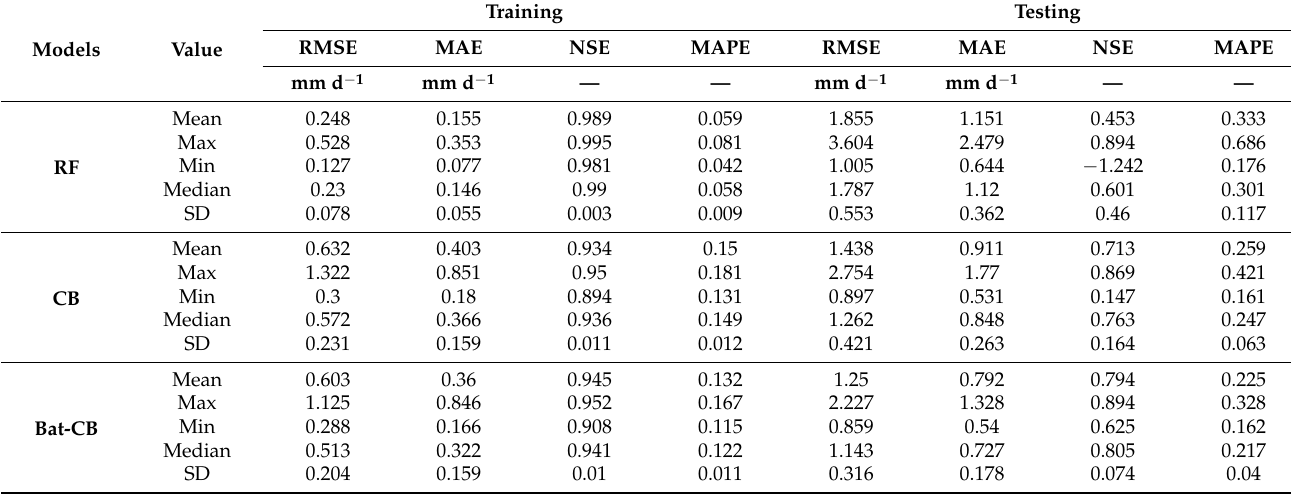
Table 2. Statistical indicators of three machine learning models for predicting the pan evaporation in northwest China.